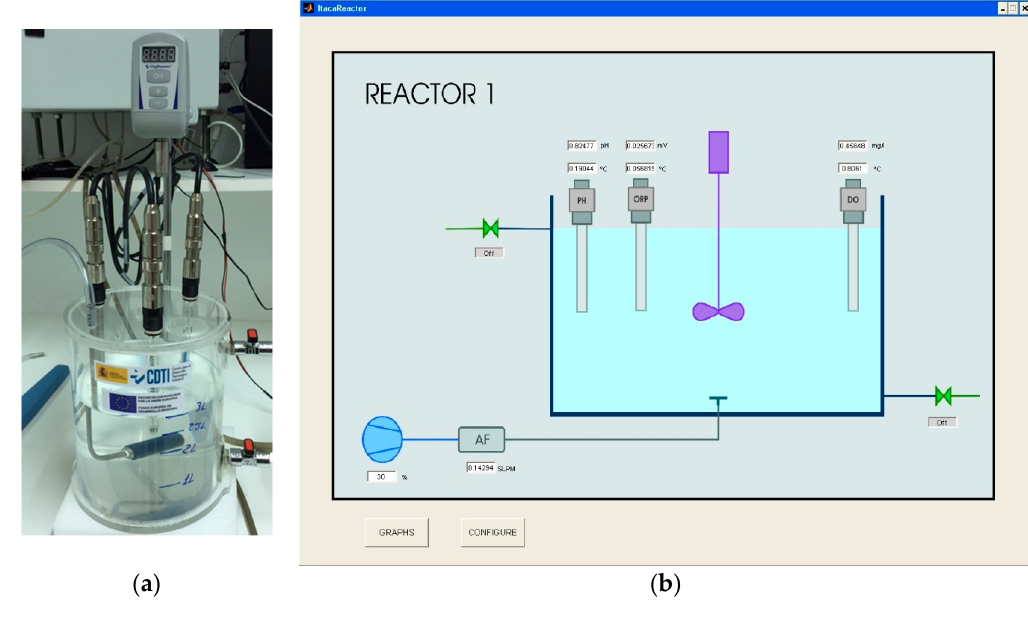
Figure 3. Prototype. ( a ) Picture. ( b ) Diagram.